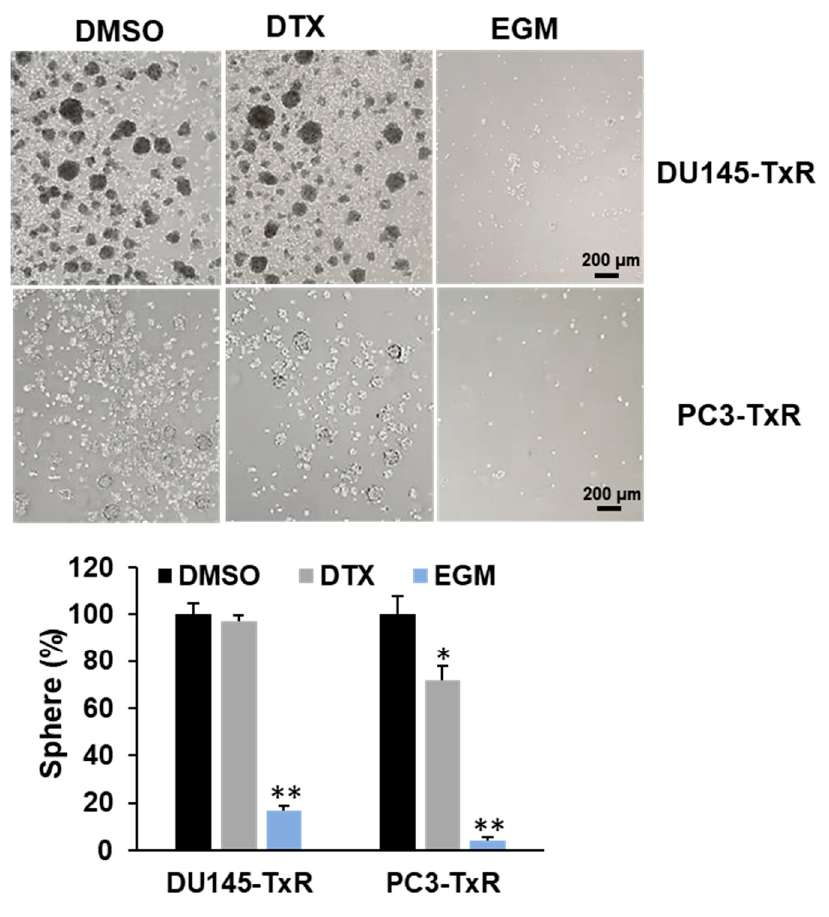
Figure 6. Eggmanone inhibits sphere formation in chemo-resistant prostate cancer cells.Sphere formation assay in chemo-resistant DU145-TxR and PC3-TxR cells treated with vehicle DMSO, 1 nM Docetaxel (DTX) and 3 µ M Eggmanone (EGM). (* p < 0.05, ** p < 0.01).